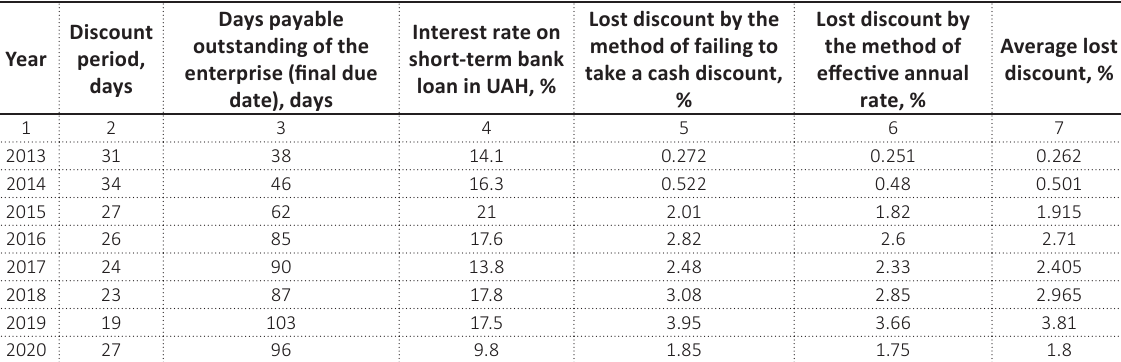
Table 4. Potential penalties of Lagoda